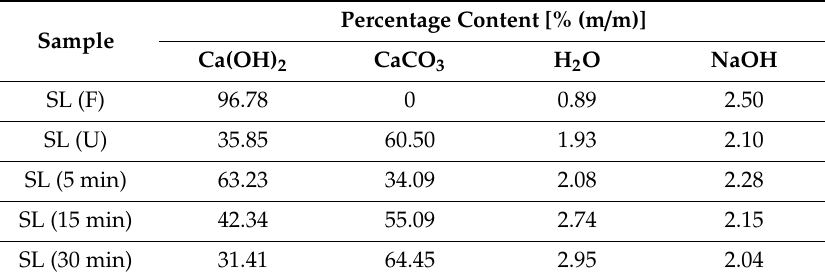
Table 1. Composition of investigated samples.